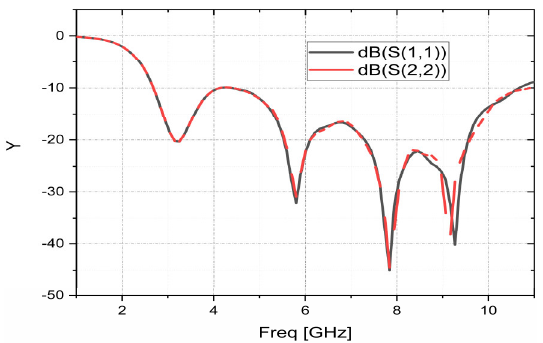
Figure 14. Group delay.